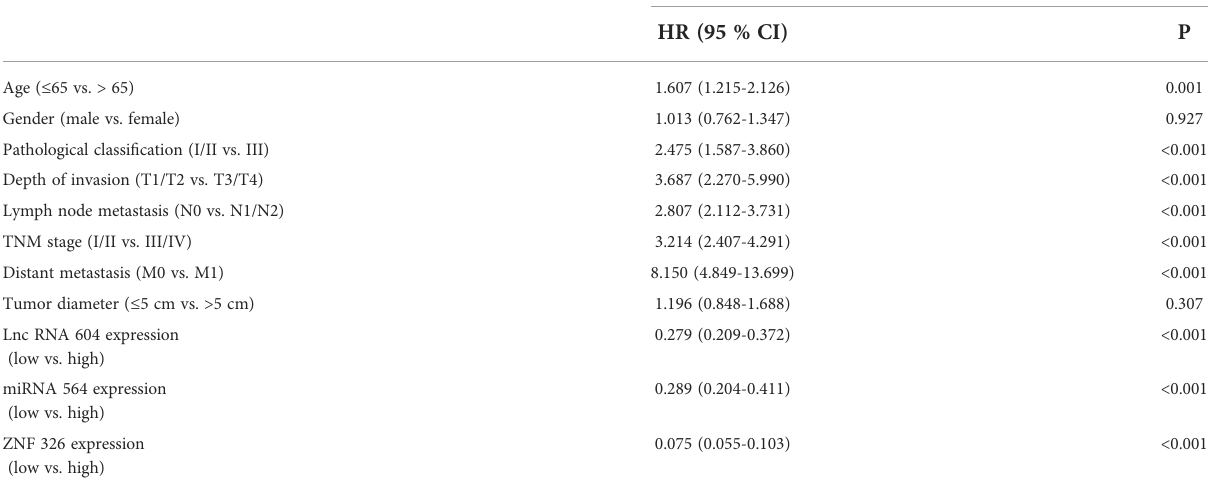
TABLE 2 Univariate Cox regression analysis of Lnc RNA 604, miRNA 564, ZNF326 expression and clinicopathological variables predicting survival in CRC patients.